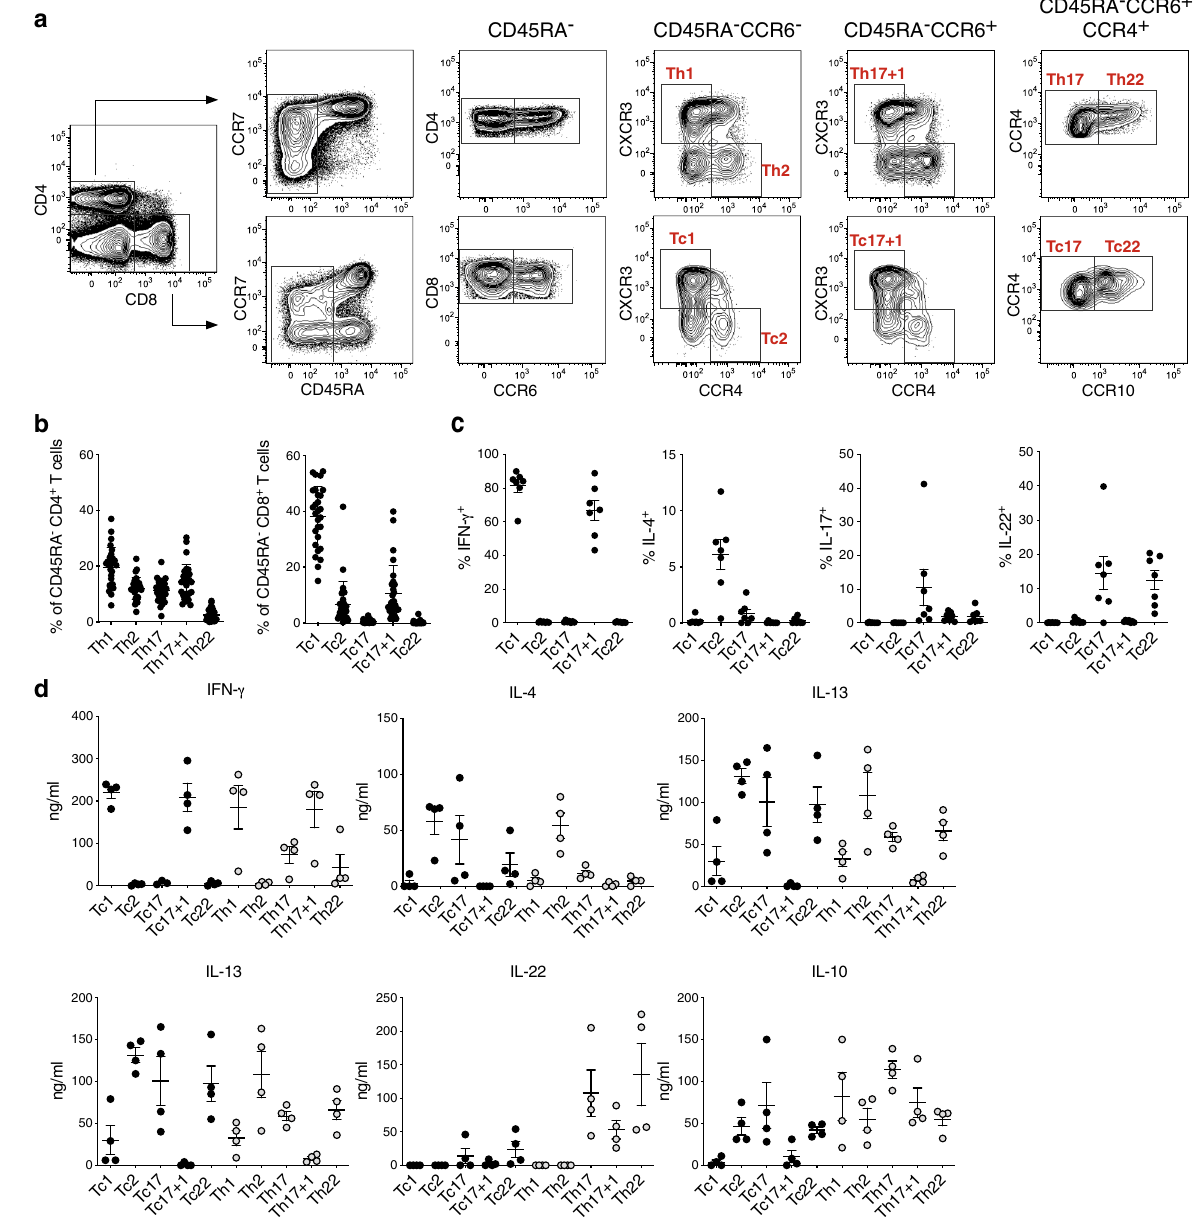
Fig. 1 Chemokine receptors identify CD4 + and corresponding CD8 + memory T-cell subsets. a Representative FACS plot of chemokine receptor-based gating strategy in PBMC. Th/Tc subsets were gated within CD45RA − CD4 + or CD8 + memory T cells as following: Th1/Tc1 CCR6 − CXCR3 + CCR4 − , Th2/Tc2 CCR6 − CXCR3 − CCR4 + , Th17 + 1/Tc17 + 1 CCR6 + CXCR3 + CCR4 − , Th17/Tc17 CCR6 + CXCR3 − CCR4 + CCR10 − , and Th22/Tc22 CCR6 + CXCR3 − CCR4 + CCR10 + . b Percentage of CD45RA − CD4 + and CD8 + T cells expressing the de fi ned chemokine receptor pattern for the speci fi c Th- or Tc-cell subsets respectively ( n = 28), mean ± SEM. c Frequencies of cytokine secreting cells among sorted and polyclonally activated Tc-cell subsets ( n = 7), mean ± SEM. d Sorted Tc- (black circles) and Th- (gray circles) cell subsets were stimulated for 72 h and the cytokine concentrations of the supernatants assayed by Multiplex ELISA ( n = 4 for each subset), mean ± Tc2, Tc17, and Tc22 cell subsets, and clustered the latter ones with Despite their striking similarity, Tc1 and Tc17 + 1 cells clearly the CD4 + T-cell subsets, we assumed that they might represent a differ from each other in the expression of several genes, such as CD8 + T-cell fraction with CD4 + helper T-cell characteristics IL23R , IFNGR1 , VCAM1 , CD38 , TIGIT , and CCR1 , while Tc2, (Supplementary Fig. 2b). Gene ontology overrepresentation ana- Tc17, and Tc22 cells share different combinations of genes, lysis (ORA) displayed a high enrichment of immunoregulatory including PTGDR2 (CRTH2), ICOS , TNFSF11 (RANK), and genes and genes that are indicative of tissue migration in helper- ITGAE (CD103; Fig. 3a). Flow cytometric analysis identi fi ed type Tc2, Tc17, and Tc22 cells, while only Tc1 and Tc17 + 1 cells perforin and granzyme B in resting Tc1 and Tc17 + 1 cells, while expressed genes associated with cytotoxicity, such as Granzymes , Tc2, Tc17, and Tc22 cells expressed the skin-homing marker CLA Perforin , CRTAM , and NKG7 (Fig. 3a and Supplementary Fig. 2c). instead (Fig. 3b, c). Upon activation, Tc2, Tc17, and Tc22 cells